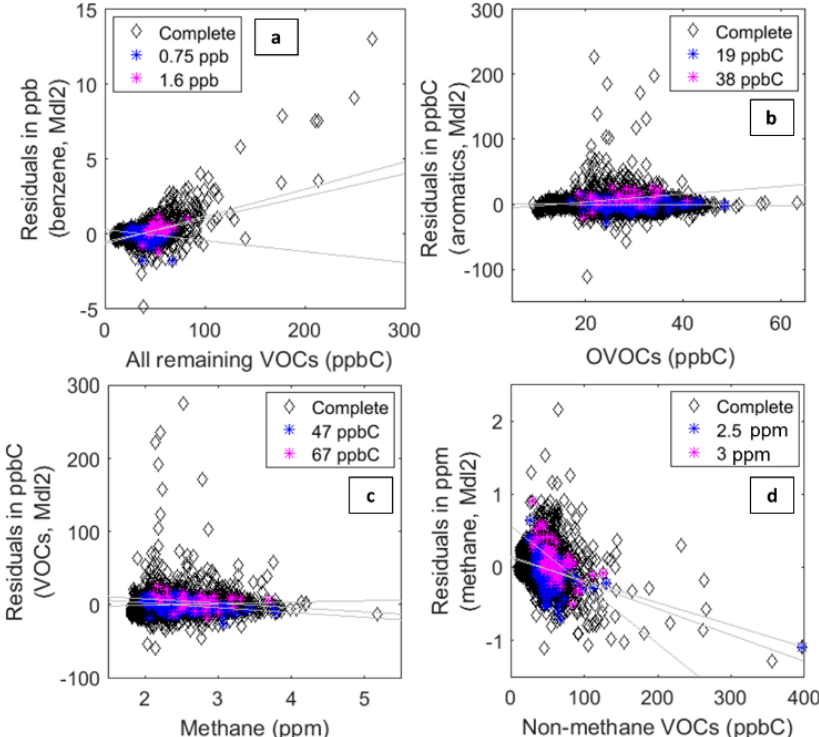
Figure 7. Complete residuals verses other non-target VOCs. The complete residuals for the Model 2 results are in black. The blue and fuchsia points that represent two values are held constant. For (a) , the constant benzene values selected were 0.75 and 1 . 6 ± 0 . 05ppb. For (b) , the summed aromatics values selected were 19 and 38 ± 1ppbC. For (c) , the summed VOC values selected were 47 and 67 ± 1ppbC. For (d) , the methane values selected were 2.5 and 3 ± 0 . 05ppm.